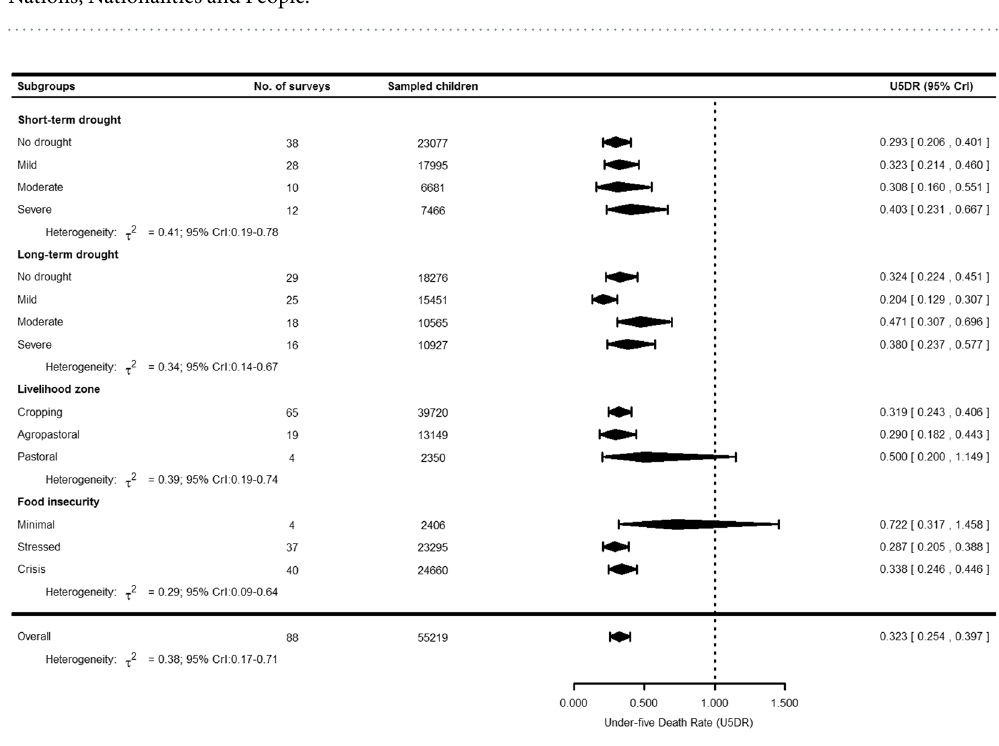
surveys were from the three highly populated regions of the country: Oromia (n = 38, 43.2%), Amhara (n = 22, 25.0%), and the Southern Nations, and Nationalities and People (n = 18, 20.5%) (Table 1). Regarding drought exposure, n = 50 (56.8%) and n = 59 (67.0%) of the surveys were conducted in areas affected by mild to severe drought in the short- and long-term, respectively. Most of the surveys (n = 65, 73.8%) were conducted in crop- ping areas (versus pastoral and agropastoral). Moreover, n = 84 of the surveys (95.1%) were conducted in areas suffering from stressed or crisis level food insecurity (Fig. 2). Pooled U5DR across the surveys, subgroup meta-analysis and meta-regression. The forest plot in Fig. 2 shows the pooled U5DR according to the subgroups. The pooled U5DR in the study period was 0.323/10,000/day (95% credible interval, CrI: 0.254–0.397). The heterogeneity among the survey estimates was τ 2 = 0.38 (95% CrI: 0.17–0.71) (Fig. 2). The U5DR was not associated with both short- and long-term droughts (Table 2). Pastoral areas showed higher U5DR (0.500; 95% CrI: 0.200–1.149) (Fig. 2), but there was no plausible difference compared to agropastoral areas (Table 2) which had U5DR of 0.290 (95% CrI: 0.182–0.443) (Fig. 2). (DRR = 2.36; 95% CrI: 1.05–5.02 Model 1; DRR = 2.36; 95% CrI: 1.09–4.68 Model 2) (Table 2). Every one-percent